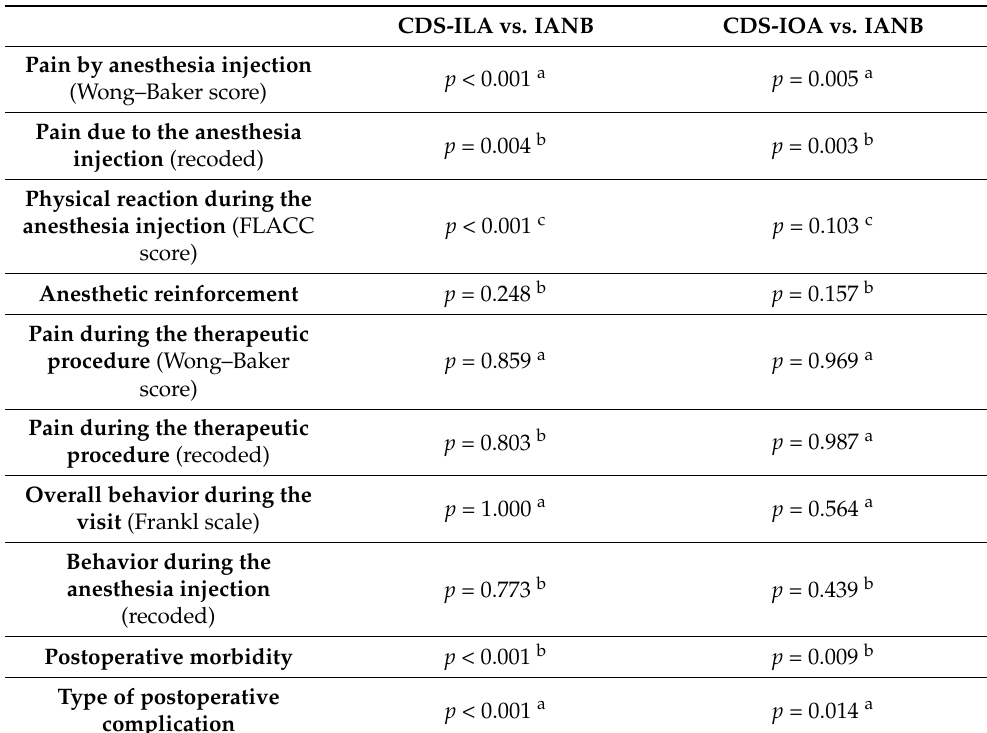
Table 2. Statistical significance of the differences between the values of the outcome variables (first column), obtained from the study group according to the applied anesthesia